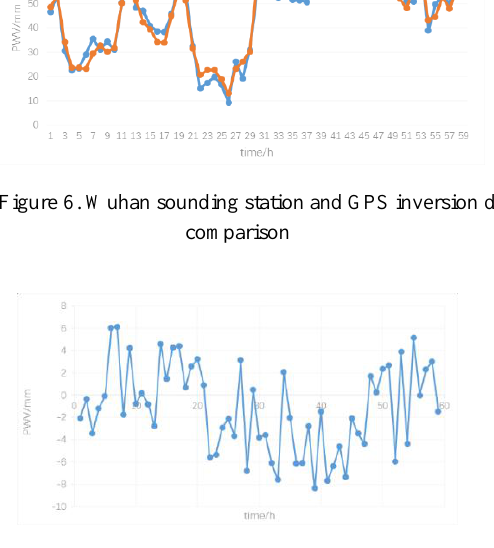
Figure 7. Wuhan sounding station and GPS inversion data